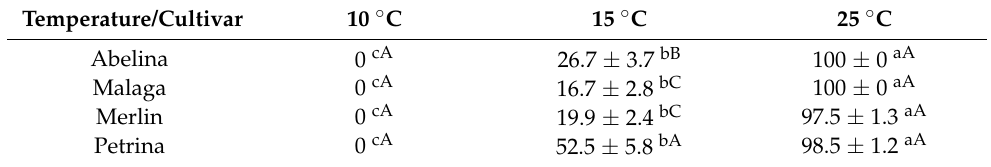
Table 1. Percentage (%) of seeds of four soybean cultivars germinated after 48 h at different temperatures. Temperature/Cultivar